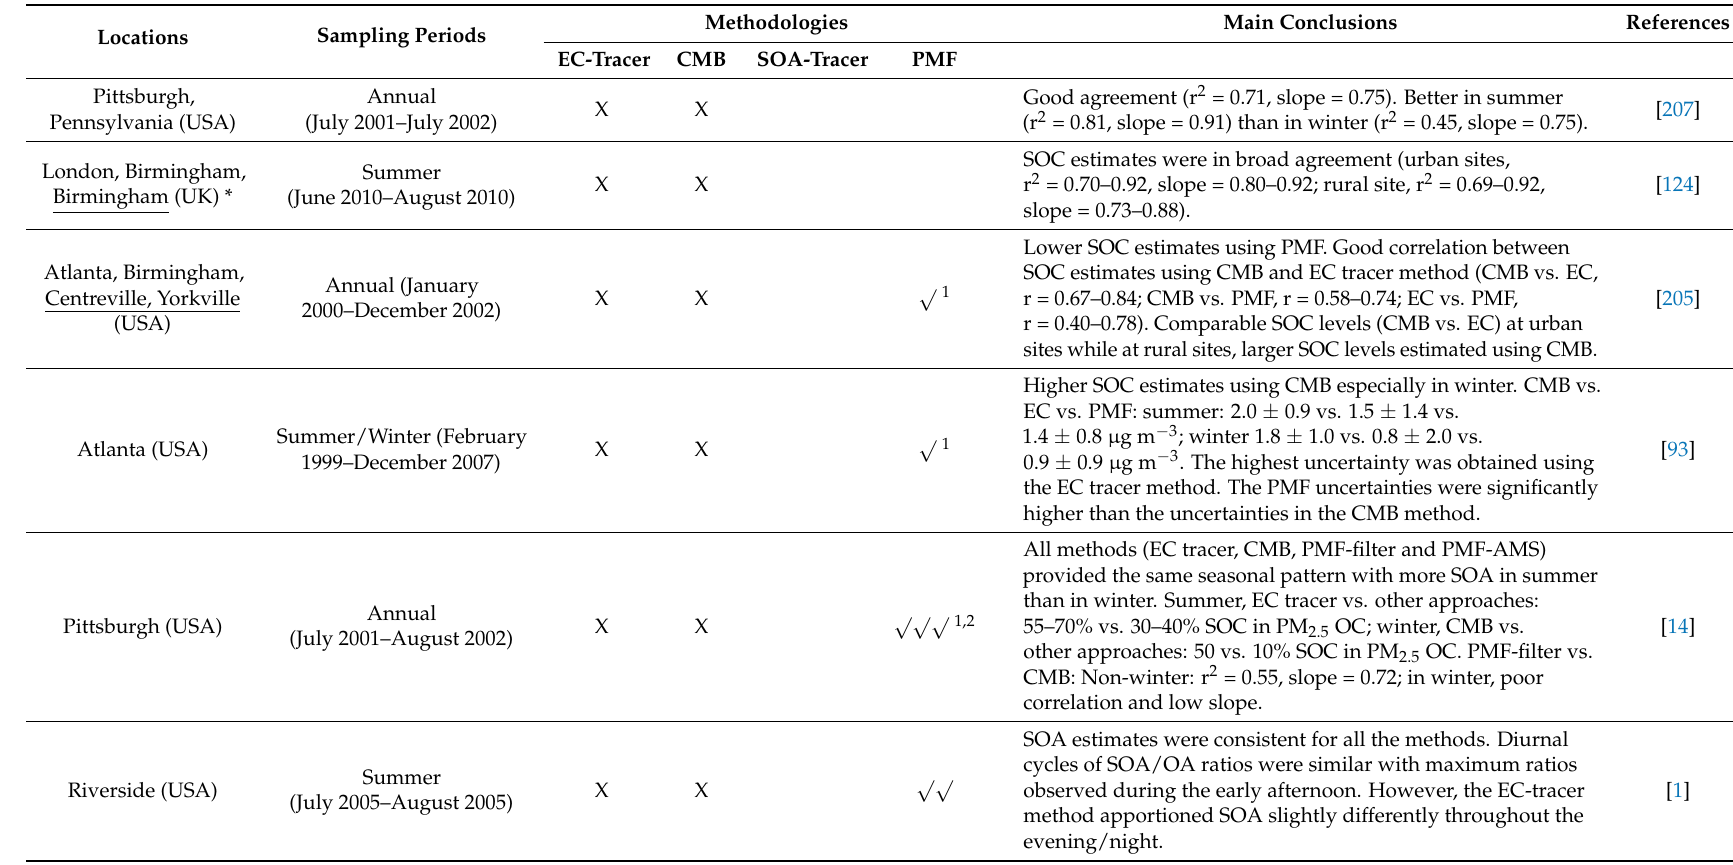
Table 1. List of the studies reporting a direct comparison of SOC contributions evaluated using different